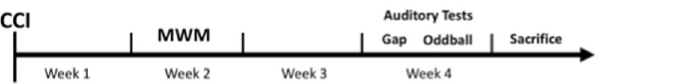
Figure 5. Timeline for behavioral studies including relative dose timing and weeks of MWM and auditory